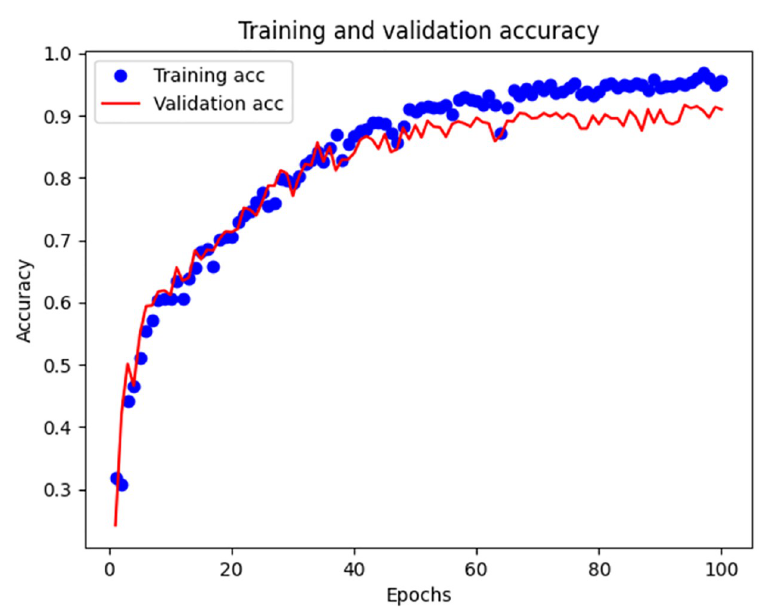
Fig 6. Variation of